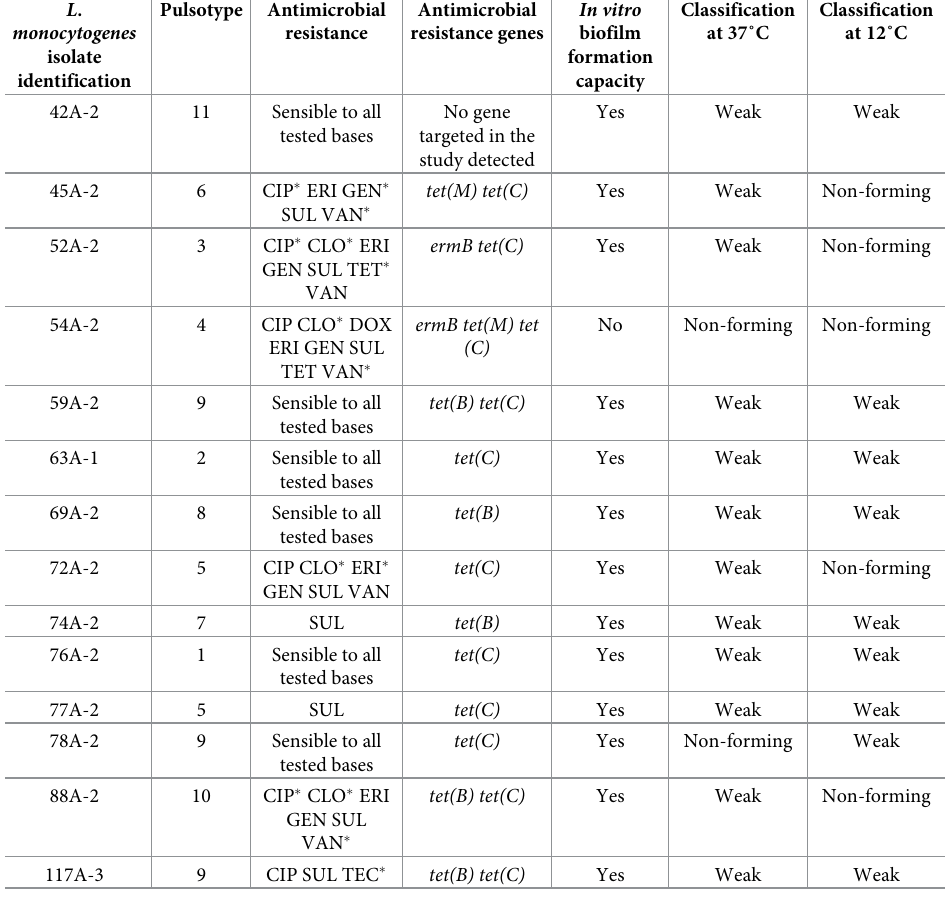
� Antimicrobial agents with intermediate